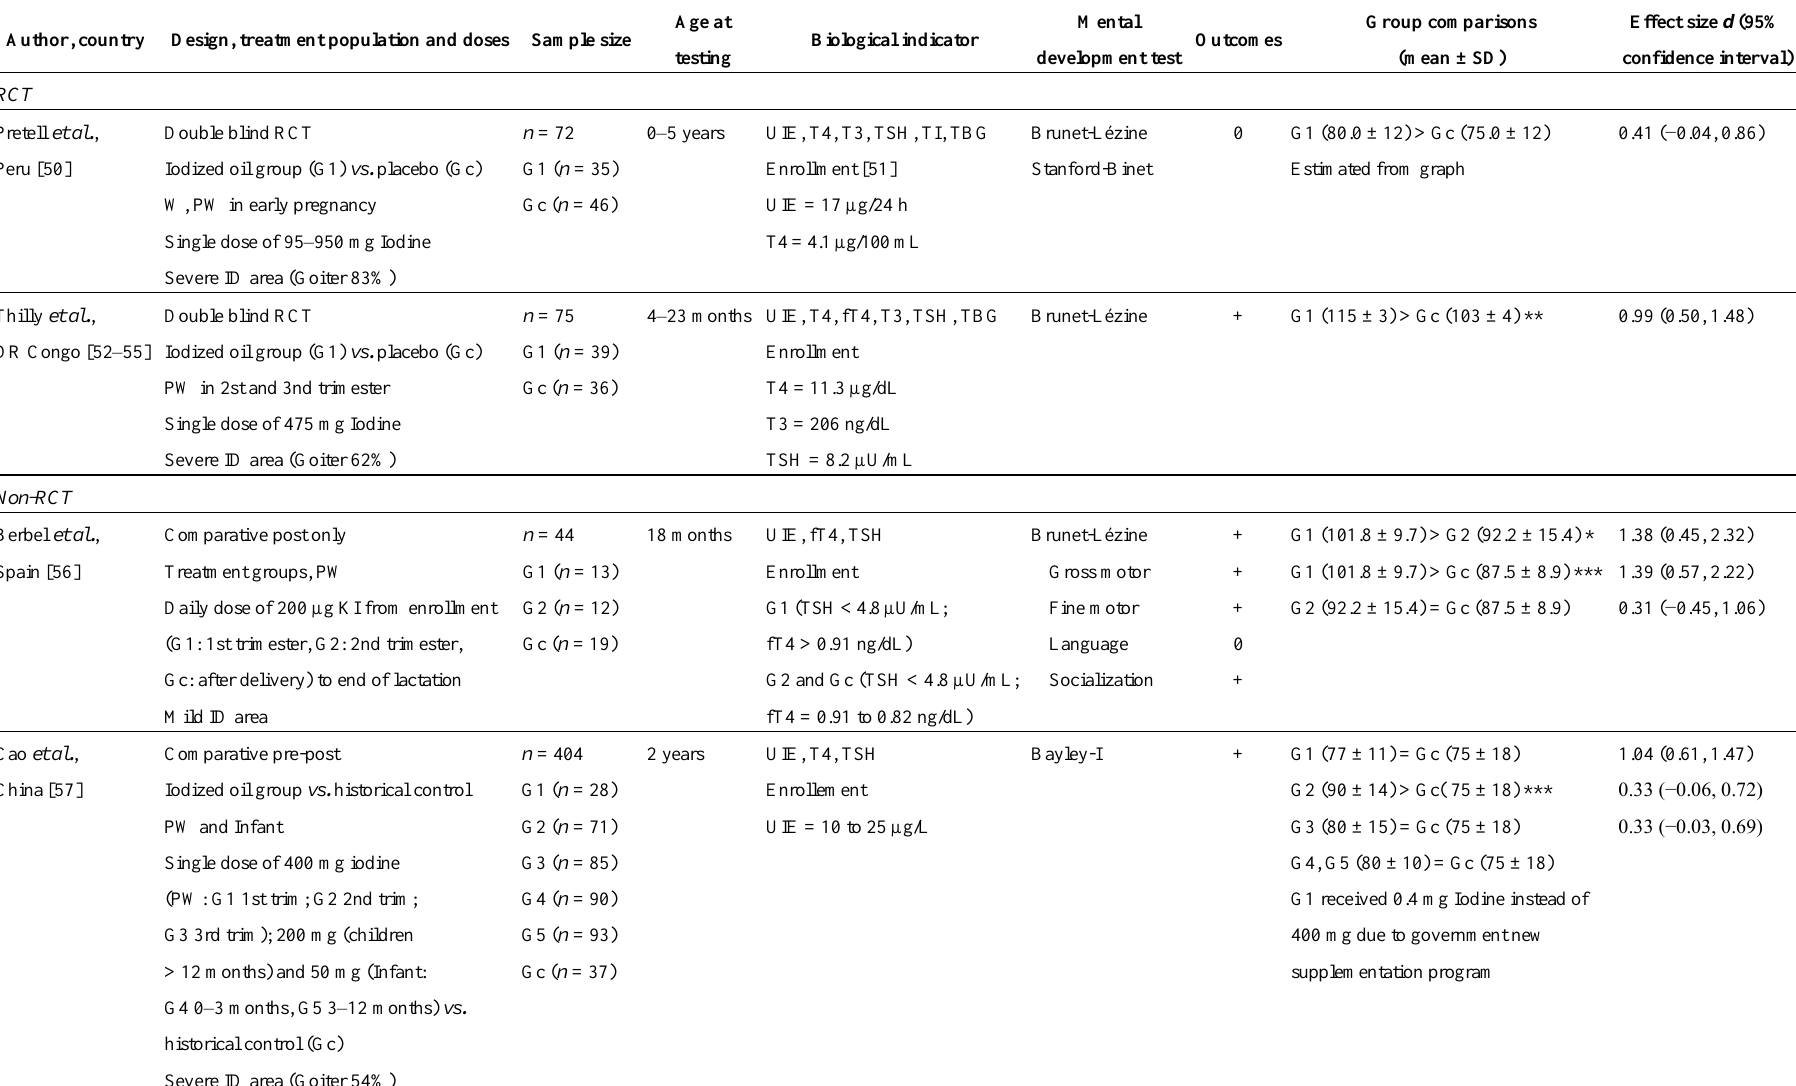
Table 1. Intervention